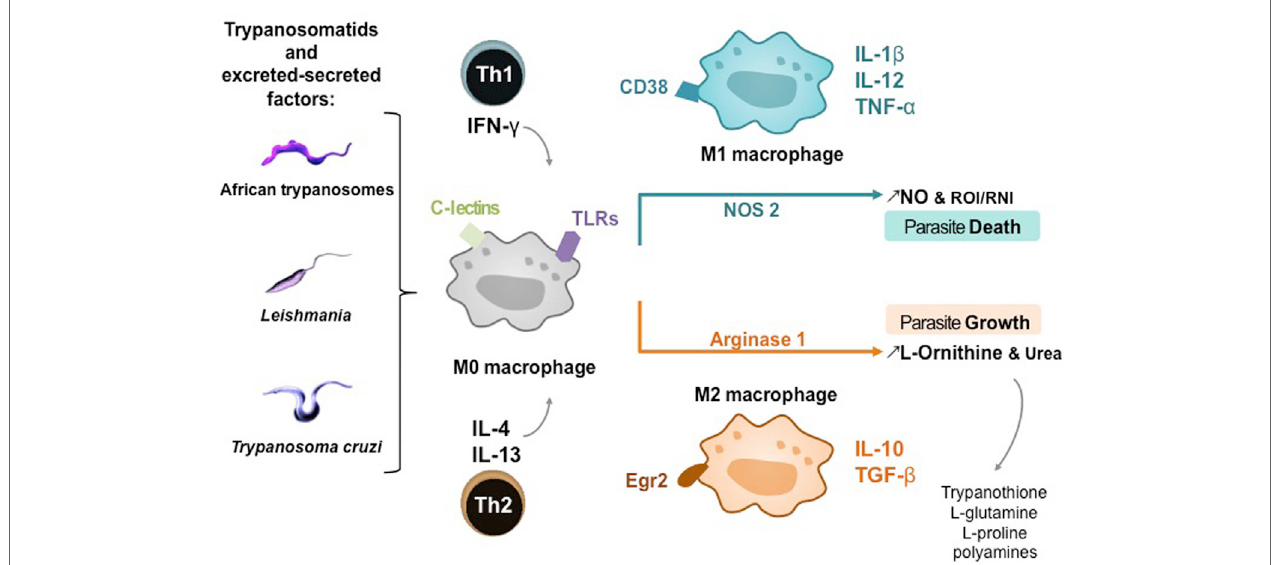
FiGURe 2 | Macrophage activation pathways in trypanosomatid infections. T-cell subsets potentiating M0 macrophage differentiation into M1 or M2 subtype; Th, helper T lymphocyte; IFN- γ , interferon- γ ; IL, interleukin. Host cell receptors involved in trypanosomatid detection: C-lectins and toll-like receptors (TLRs). Phenotypic markers and cytokines of macrophage polarization: cluster of differentiation (CD) 38, Egr2, early growth response protein 2; TNF- α , tumor necrosis factor; TGF- β , transforming growth factor. Products of macrophage polarization influencing the death or growth of trypanosomatids; NO, nitric oxide.